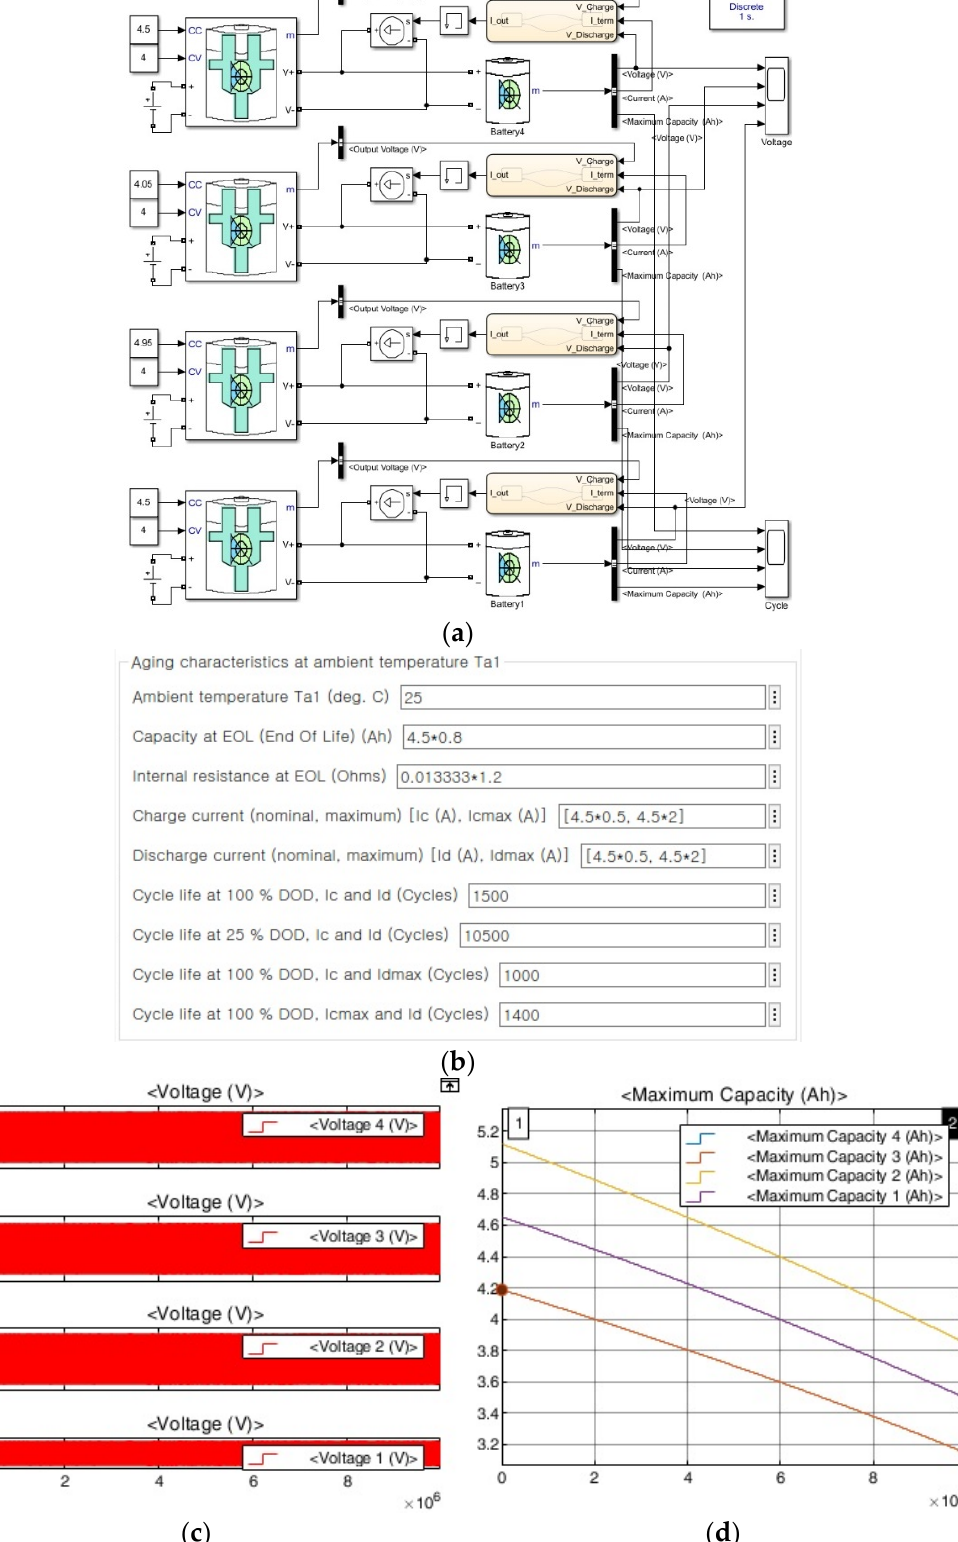
Figure 7. Aging simulation for single-cell charging with capacity differences. ( a ) Schematic. ( b ) Battery settings. (c) Voltage results. (d) SOH results.